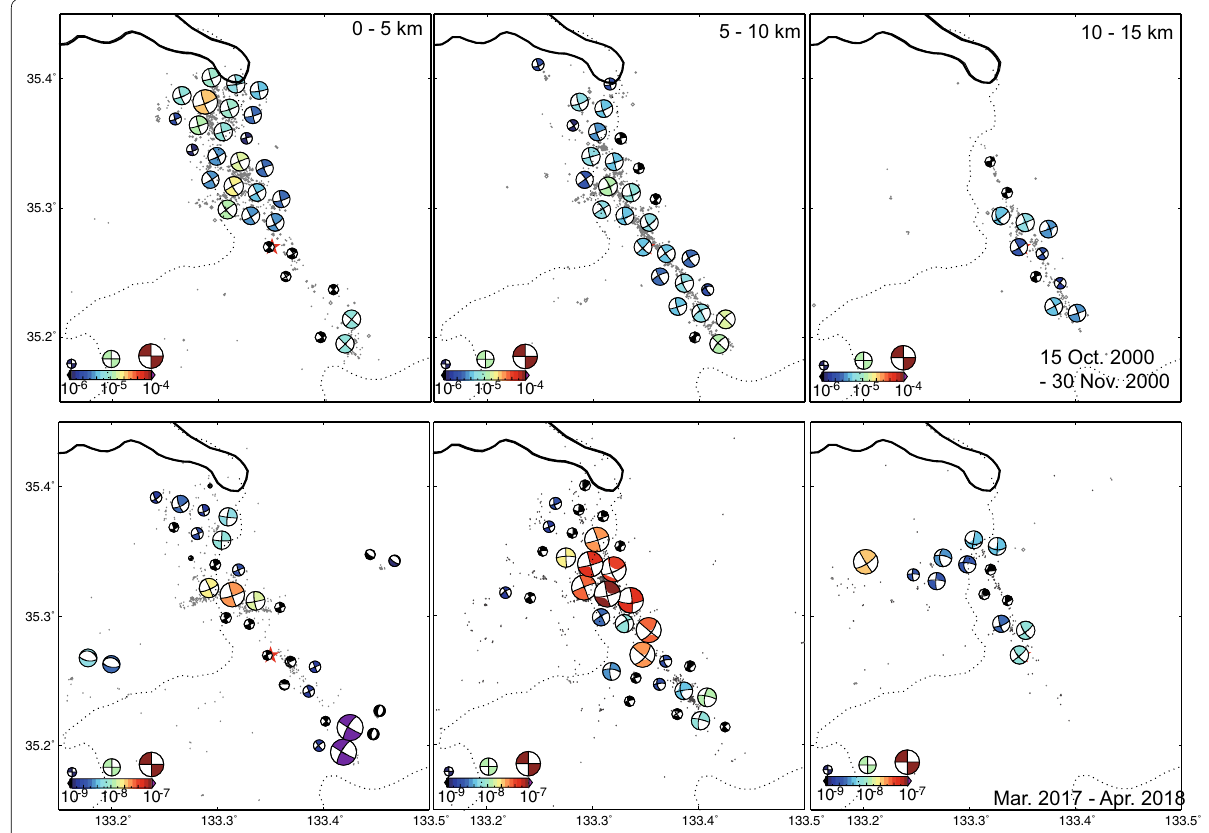
Fig. 5 Map showing the inelastic strain rate tensors estimated from the two periods of data in spatial blocks. The tensor is plotted on the lower hemisphere in a similar way to the seismic moment tensor. The upper and lower maps show the results from Oct 15, 2000 to Nov 30, 2000 and from Mar 2017 to Apr 2018, respectively. The figures on the left, middle, and right correspond to the depth ranges shown at the top of the figure. The symbol sizes and colors reflect the magnitude of the inelastic strain rate, as shown in the legend at the lower left of each map. Gray dots are epicenters within the depth range for each